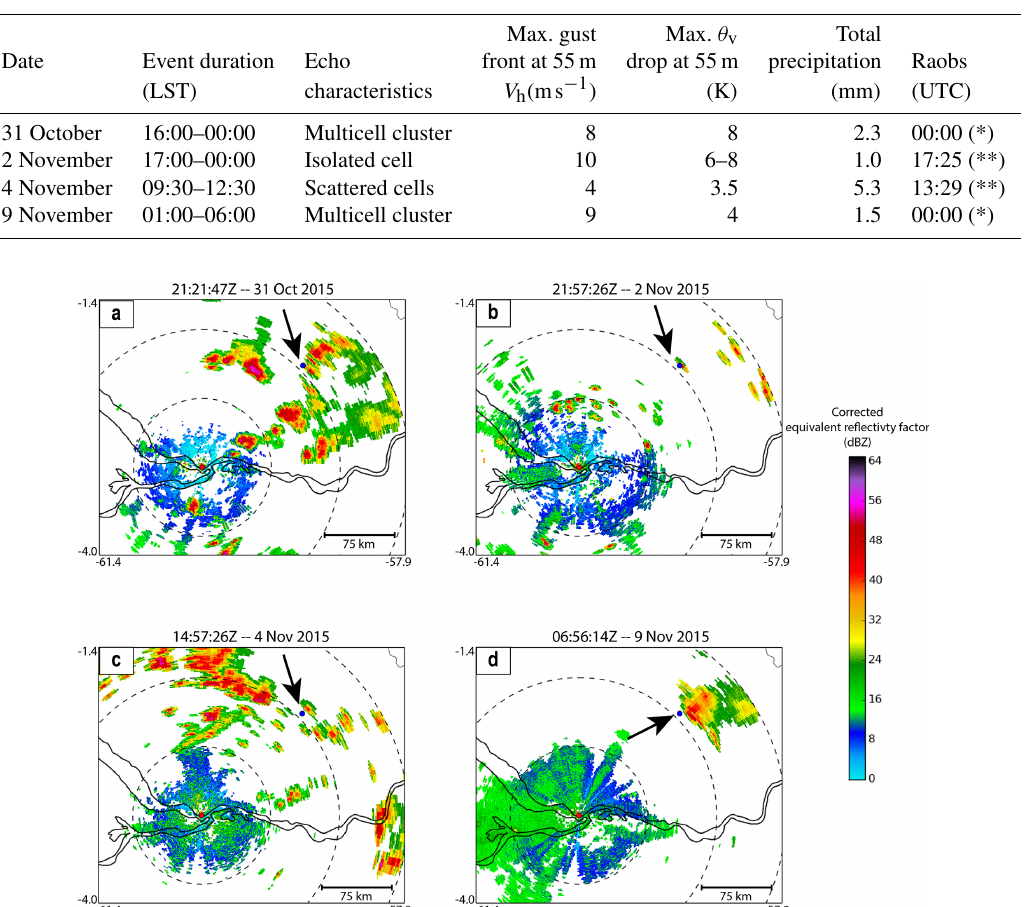
Figure 1. 0.9 ◦ PPI reflectivity imagery from the Manaus Doppler radar for the four DMC events studied. (a) 17:21LST on 31 October 2015, (b) 17:57LST on 2 November 2015, (c) 10:57LST on 4 November 2015, and (d) 02:56LST on 9 November 2015. The red (blue) dot shows the location of Manaus (ATTO tower). The concentric dashed lines around the radar site are the 75, 150, and 225km radar range circles. The black arrow indicates the convective elements that were sampled at the walk-up